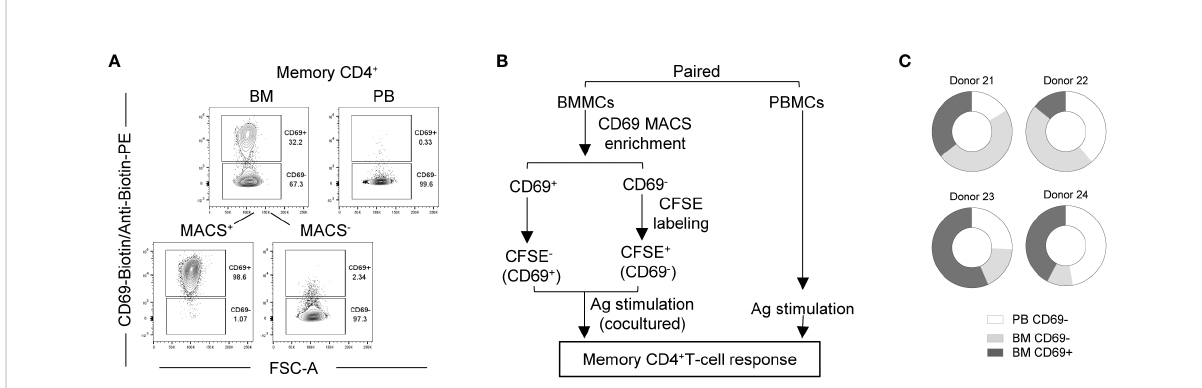
FIGURE 3 Bone marrow contains CD69 + and CD69 - SARS-CoV-2 reactive memory CD4 + T cells. Bone marrow CD69 + and CD69 - cells from four vaccinated donors were analyzed for their memory CD4 + T cell response to SARS-CoV-2 in comparison with that of paired blood. (A) Representative plots showing CD69 expression by memory CD4 + T cells from a paired blood and bone marrow samples pre- and/or post- MACS. (B) Experimental scheme. (C) Estimated absolute numbers of SARS-CoV-2-reactive CD154 + cytokine + memory CD4 + T cells using the frequency (Supplemental Figure 3C) of these cells and the estimated numbers of T cells within BM and PB of healthy young adults as described in Figure